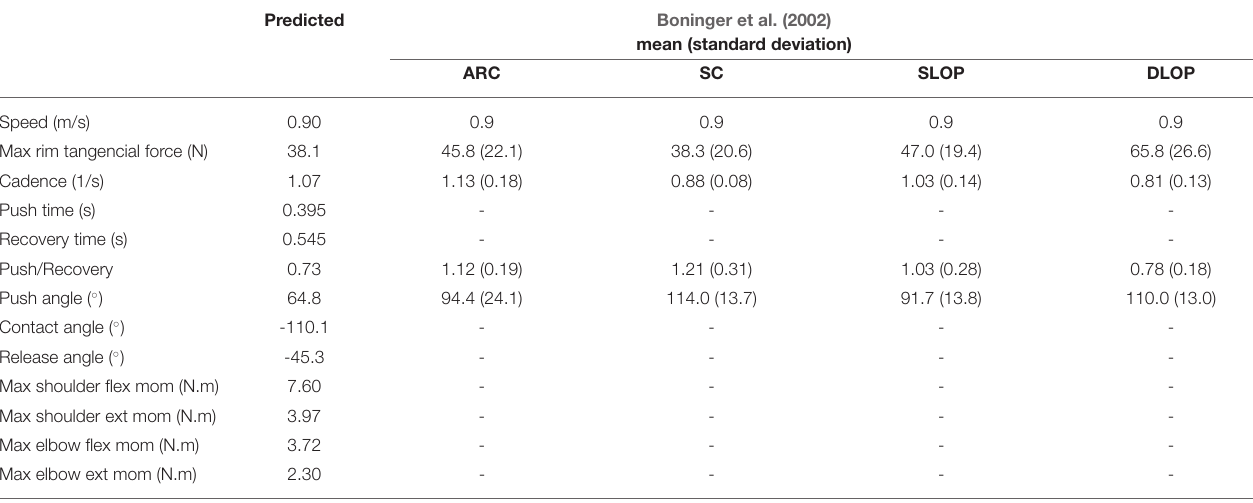
TABLE 3 | Comparison of kinematic, kinetic and spatiotemporal parameters of the steady state simulation at 0.9 m / s to experimental data reported in Boninger et al. (2002) for locomotion at 0.9 m / s .